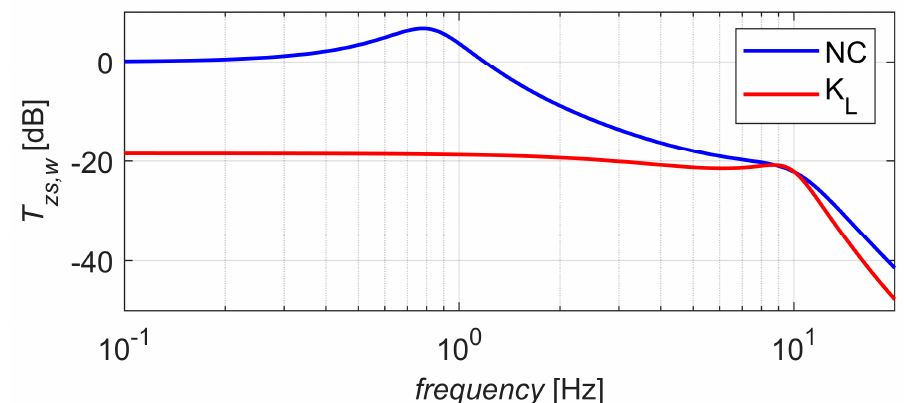
Figure 3. Vibration transmissibility functions for a suspension strut with no controller (NC) and state controller ( K L